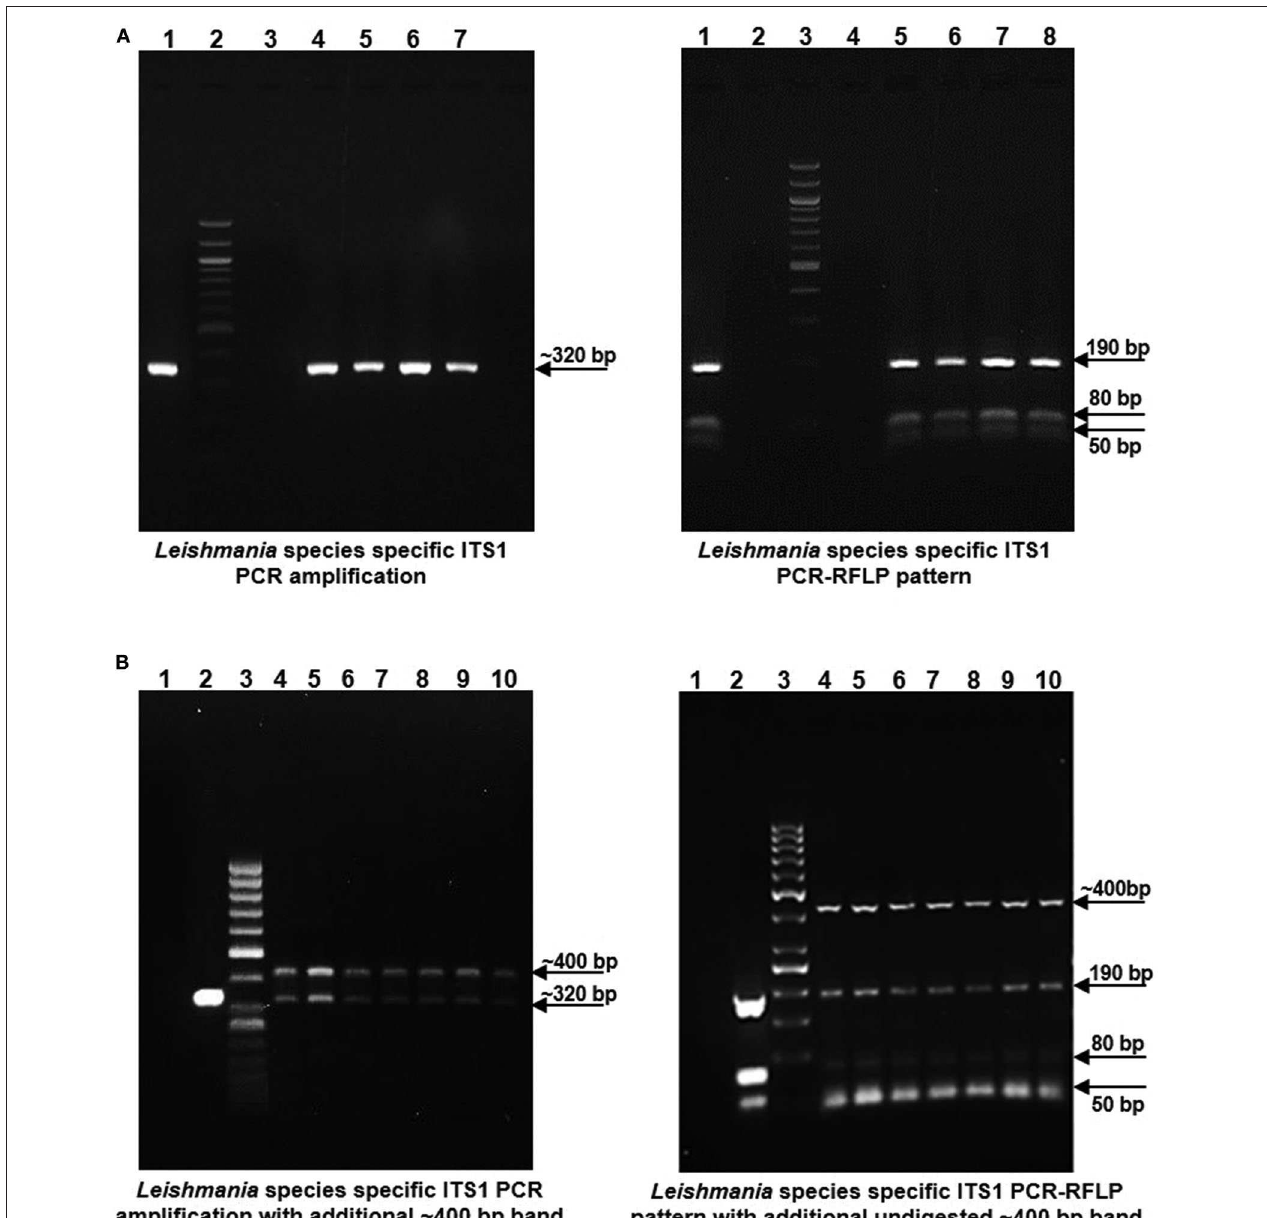
FIGURE 1 | Leishmania species specific ITS1 PCR on DNA isolated from lesion biopsy samples from CL patients and HaeIII PCR RFLP analysis of ITS1 region of test samples and L. donovani culture as a positive control. (A) Left Panel: Representative patient samples with a single, Leishmania spp specific ∼ 320 bp amplification product. Lane 1, L. donovani ; Lane 2, 100 bp DNA marker; Lane 3, water control; Lanes 4–7, CL test samples. Right Panel: HaeIII ITS1 PCR-RFLP pattern for identification of Leishmania species. Lane 1, L. donovani ; Lane 3, 100 bp marker; Lane 4, water control; Lanes 5–8, CL test samples. (B) Left Panel: Representative patient samples with dual amplification bands ( ∼ 320 bp and ∼ 400 bp). Lane 1; Water control, Lane 2; L. donovani positive control, Lane 3; 50 bp DNA marker, Lanes 4–10, CL test samples. Right Panel: HaeIII ITS1 PCR-RFLP pattern of samples with dual bands. Lane 1; Water control, Lane 2; L. donovani positive control, Lane 3; 50 bp DNA marker, Lanes 4–10, CL test